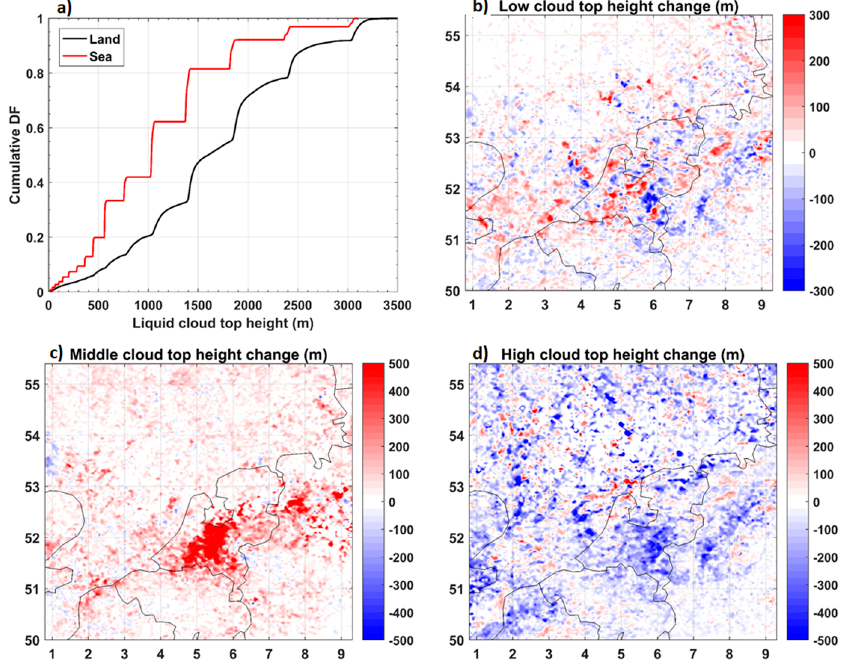
Figure 13. Cumulative distribution function of liquid cloud top height (CTH) above the land (black) and sea (red) ( a ), top change of low (100 < CTH < 800 m) ( b ), middle (800 < CTH < 1500 m) ( c ), and high liquid cloud (CTH > 1500 m) ( d ).